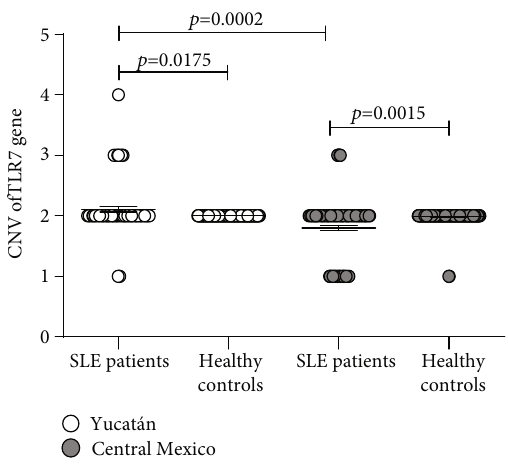
Figure 1: Distribution of CNV of the TLR7 between SLE patients and healthy controls from Yucatán and Central Mexico. Di ff erences in CNV between patients and controls were analyzed as described in Material and Methods. p values < 0.05 were considered signi fi